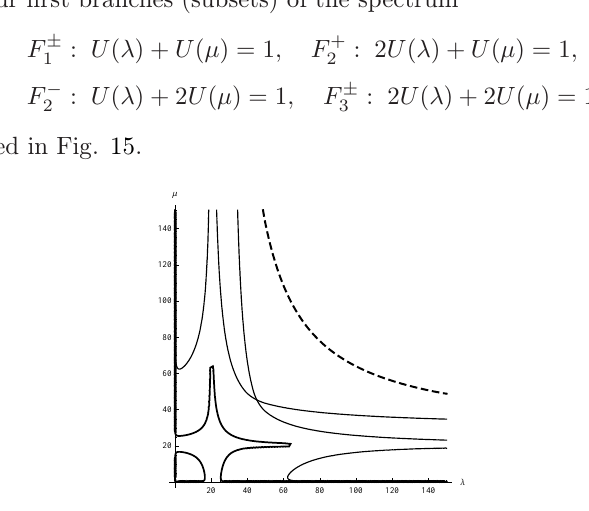
Figure 15. F ± 1 thick (there is a bounded separated component), F ± 2 thin (two parabola- looking and two hyperbola-looking infinite curves), F ± 3